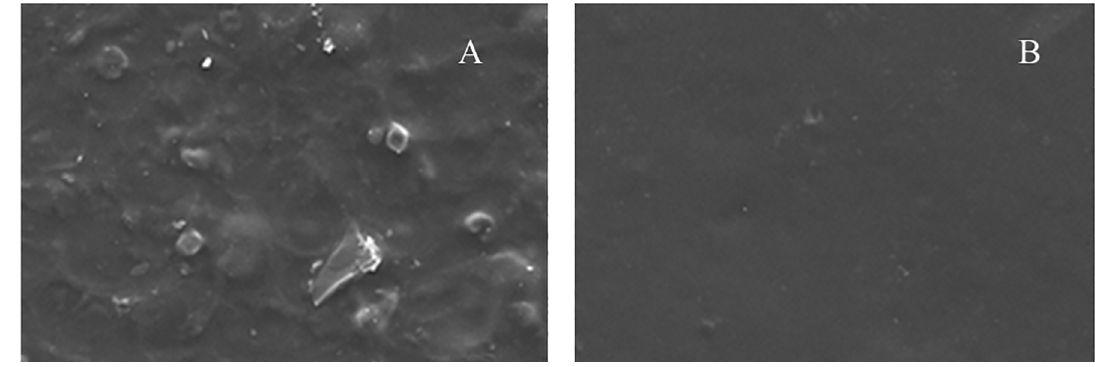
Figure 3. Macrographic aspect of welded joints. (a) GTAW. (b) FSW.